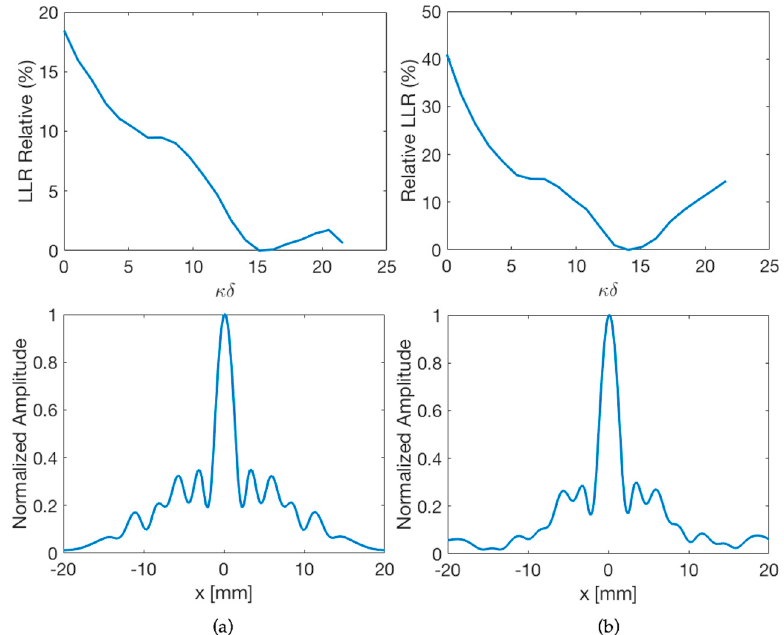
Figure 6. Outer case effect for 445 kHz PDMS-based axicon lens with cone angle φ = 130°. (Top) Relative loss of lateral resolution vs. stand-off given in number of wavelengths ( κδ ) and (Bottom) normalized pressure amplitudes of the lateral beam profile. ( a ) Lens housing with reflectivity of 0.8 dB down; ( b ) lens housing with reflectivity of 40 dB down.